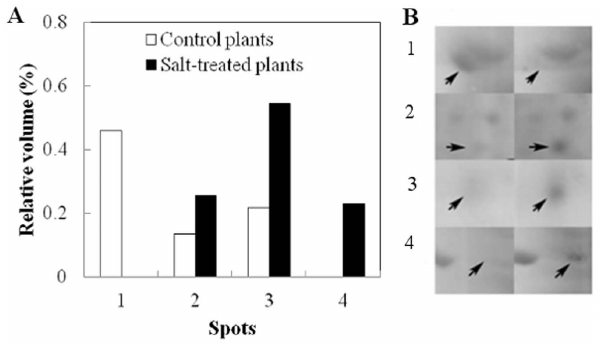
Figure 4. Relative volume of protein spots corresponding to differentially expressed proteins. (A) Quantification of protein expression and (B) Image of protein spots on gels. The left panel shows protein expression on water-treated control plants and right panel shows protein expression on salt-treated plants at day 48. Proteins were identified by mass spectrometry as being (1) fructose 1,6-bispho- sphatealdolase; (2) glyceraldehyde-3-phostate dehydrogenase; (3) germin-like protein (4) HSP70. Bars show the mean values of replicate spots.